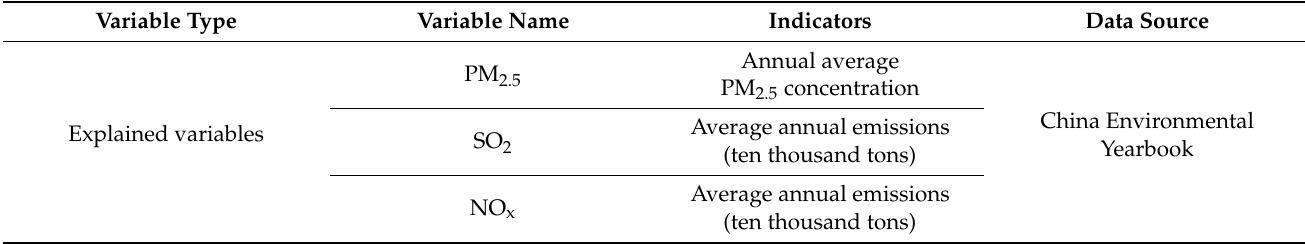
Table 1. Data sources of all